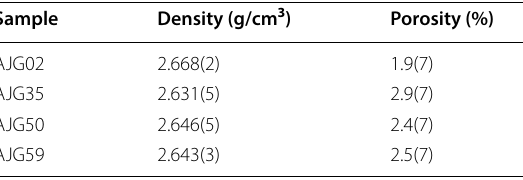
The number inside brackets shows the error in the last digit The porosity was calculated by the density method AVs( Z ) is calculated as AVs ( Z ) = | Vs ( XZ ) − Vs ( YZ ) | 1